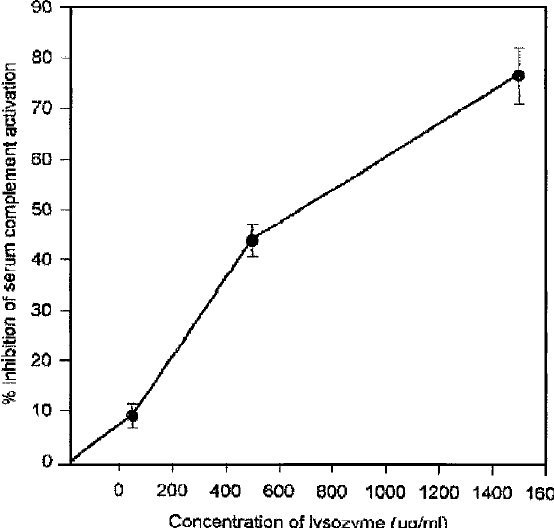
FIG. 1. Inhibitory effect of human lysozyme on serum complement activation. d , % inhibition of serum comple- ment activation (average ± SEM, n =